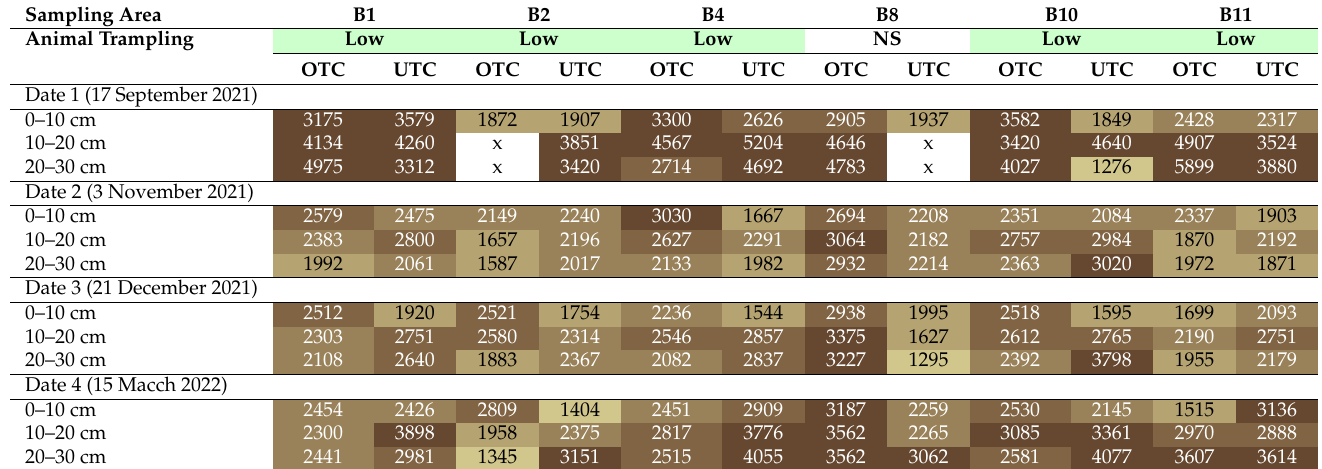
Table 5. Mean Cone Index (CI; kPa) of sampling areas of Mitra “Field B” on the four evaluation dates (2021/2022), outside and under the tree canopy (OTC and UTC, respectively), and at different depths. Sampling